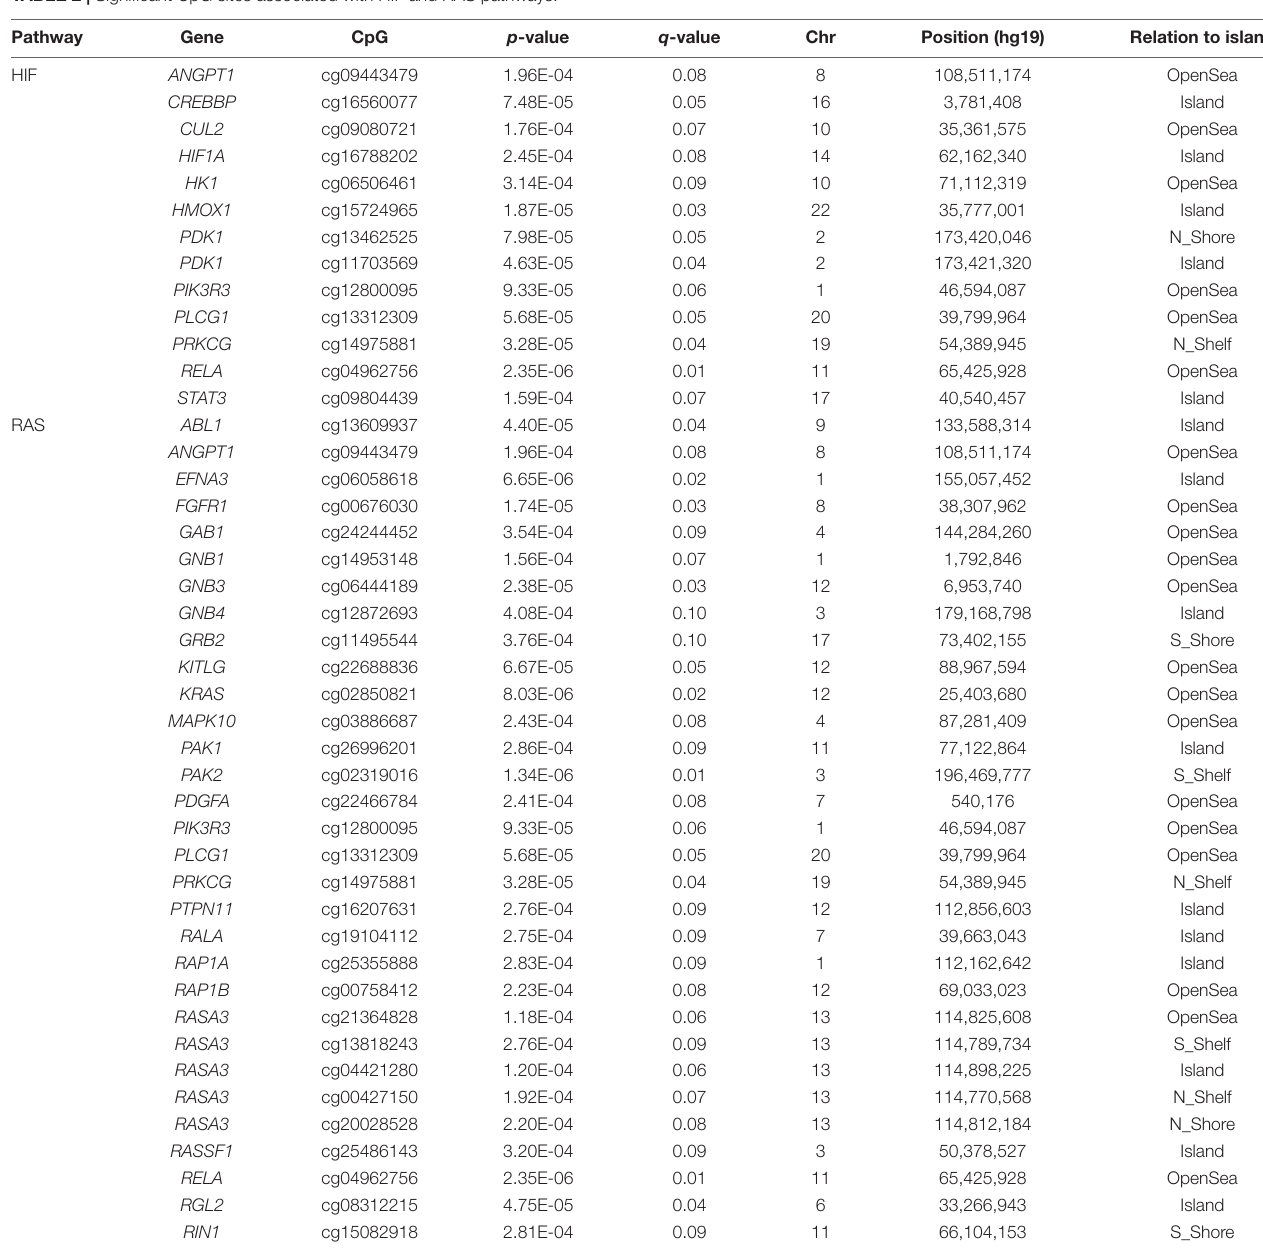
TABLE 2 | Significant CpG sites associated with HIF and RAS pathways.